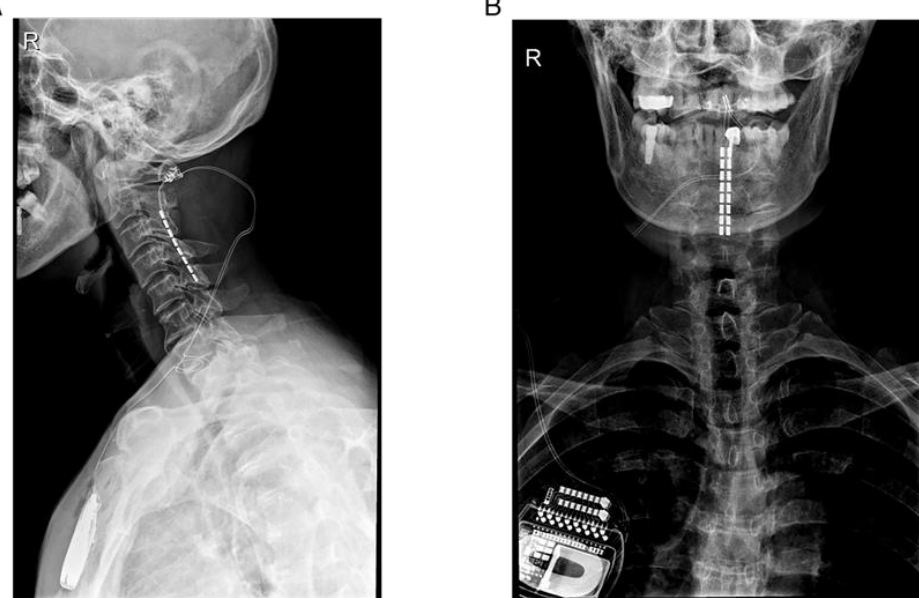
Figure 1. Representative example showing the correct positioning of the octopolar electrode at C2-C5 level by postoperative radiography. ( A ) Medial-lateral plane, ( B ) Anterior-posterior plane.